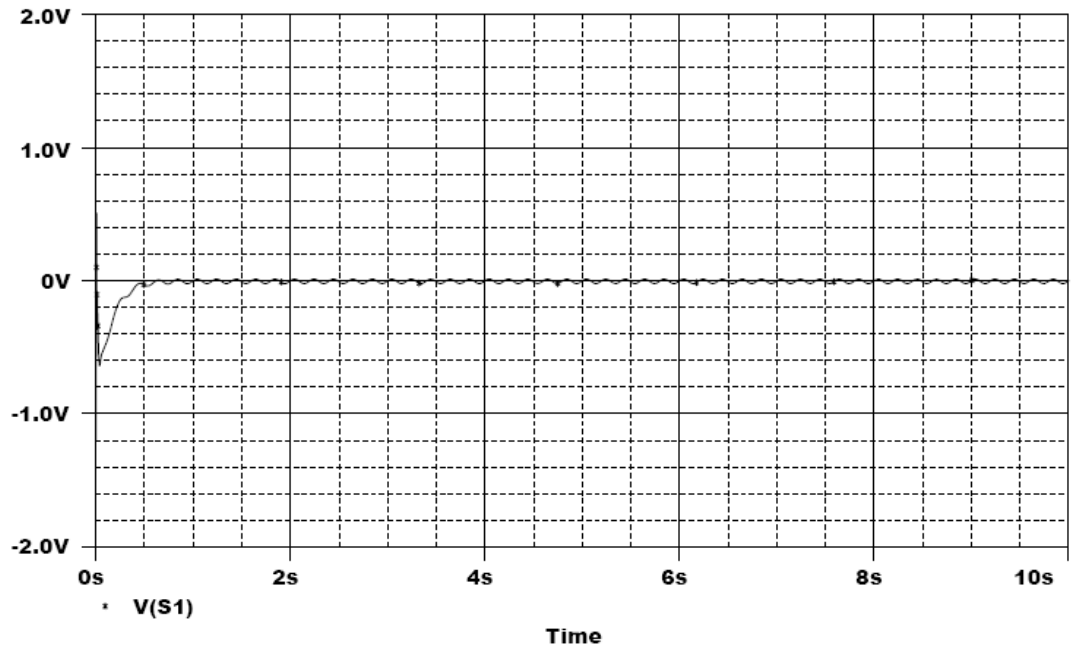
Figure 11. Experimental results of control input u